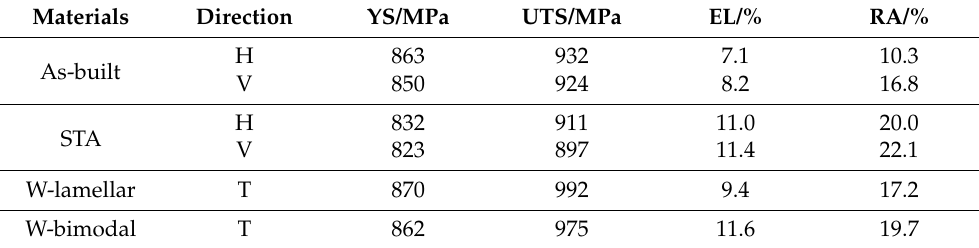
Table 3. Tensile properties for the EB-DED and wrought Ti60 alloy at room temperature.